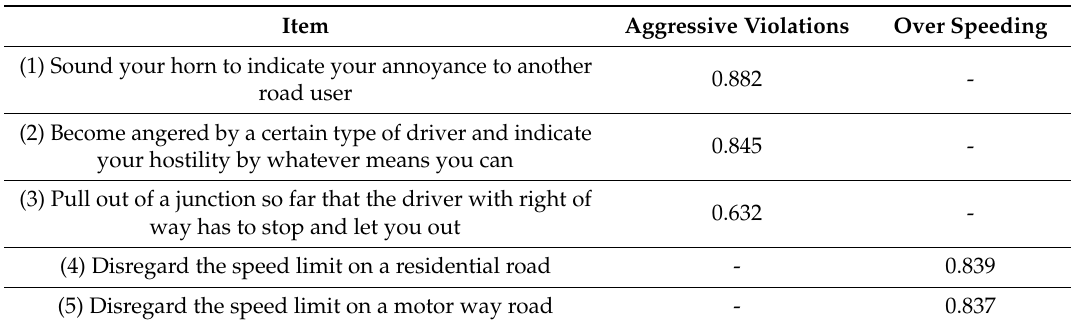
Table 5. Factor analysis results: road safety behaviours. Item